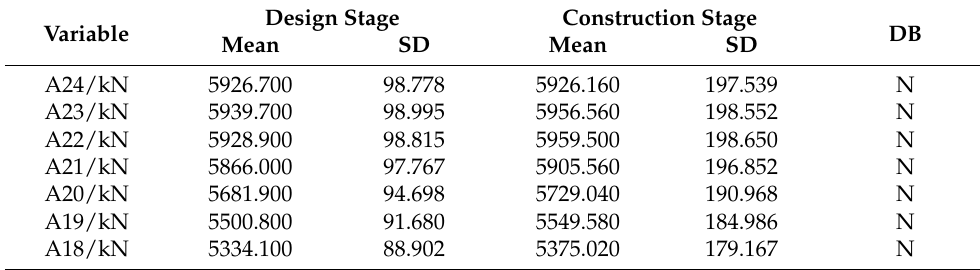
Table A1. Characters of the random variables of Yongjiang